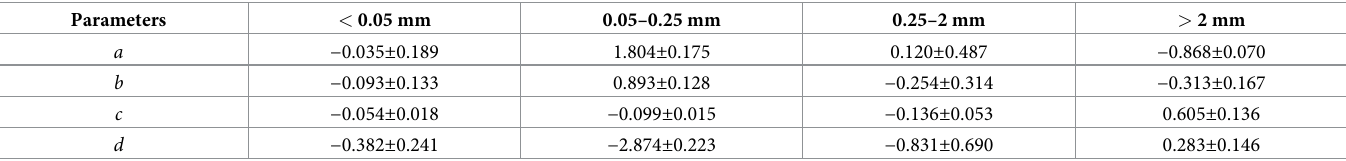
Table 5. a , b , c , and d values for the OC uneven enrichment in different size class sediments prediction function.